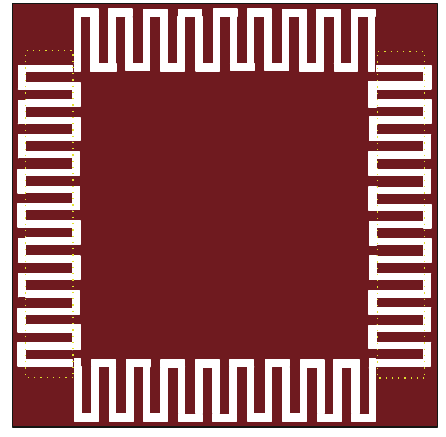
Figure 4: Structure of FSLA element.